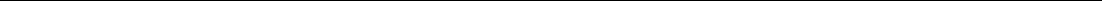
Fig. 2 Modeling results of the 40 simulated maps by MAINMAST in comparison with Pathwalking and Rosetta. a local RMSD and b structure overlap of the models by MAINMAST compared with Pathwalking models computed with the CLICK server. For the Pathwalking algorithm, data are taken from the publication in 2016. For the MAINMAST results, the model with the best threading score among the generated 2688 models were used. Structure overlap by CLICK in panel b is de fi ned as the percentage of residues in a structure placed within 3.5 Å to residues in the other superimposed structure. c , d show comparison of the models by MAINMAST and Rosetta in terms of c the global RMSD and d the coverage, which is de fi ned as the fraction of residues in a model that have some residues in the model within 2.0 Å. Solid /open circles, the highest scoring models/the best models among generated models were used for MAINMAST and Rosetta, respectively. Lines show y = x . e A histogram of correlation coef fi cients between the threading scores and RMSD of 2688 models generated by MAINMAST for the 40 EM maps. The correlation coef fi cient values are negative because the threading score is a high positive value for a near native model with a small RMSD. f correlation between the threading scores and RMSD values of models generated for 1V3W. The correlation coef fi cient is -0.767. g Comparison of C α RMSDs of models before and after the full atom reconstruction and re fi nement using Pulchra and MDFF ( g -scale used was 0.5) for the 40 maps. h Comparison of full-atom RMSDs of models before and after structure re fi nement by